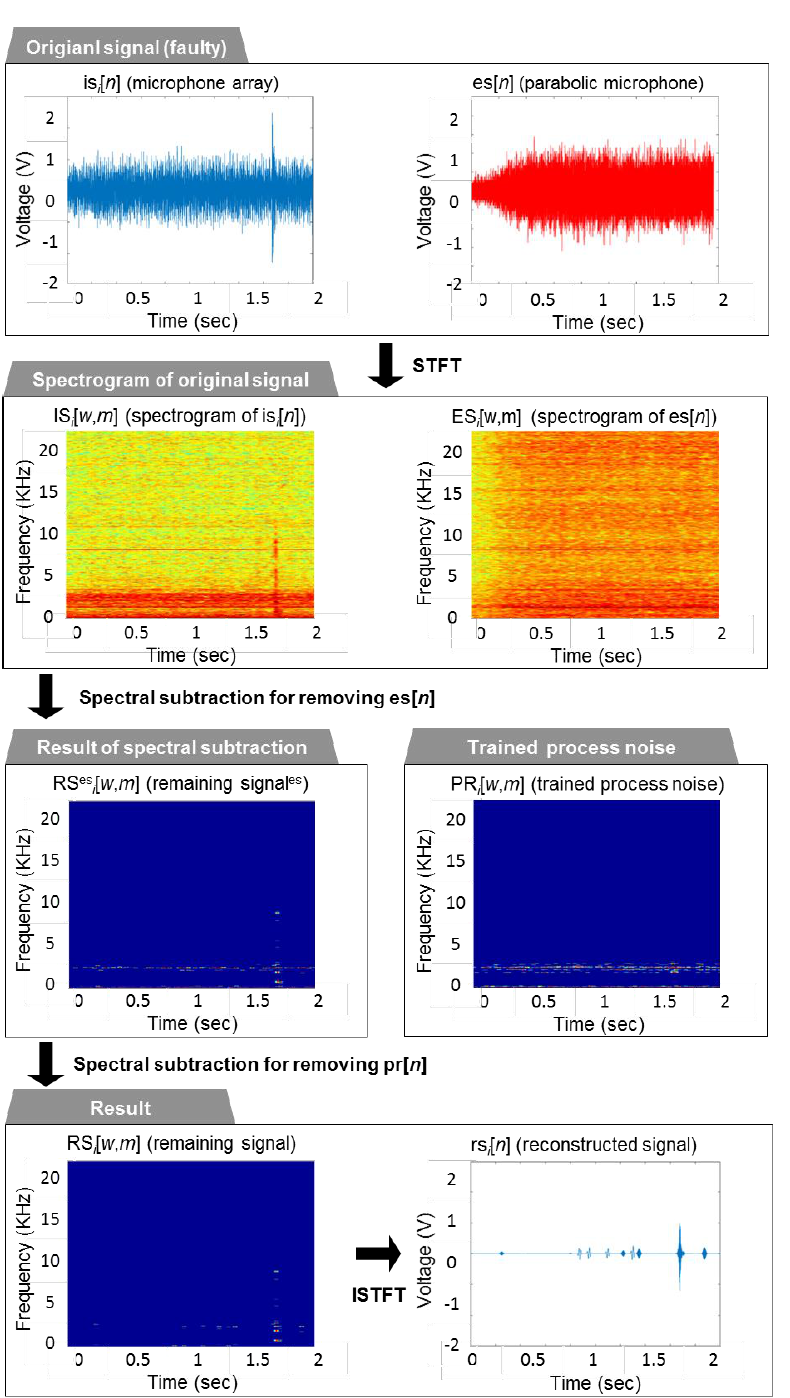
Figure 7. Noise reduction in the recorded acoustic signal from a faulty door trim panel.